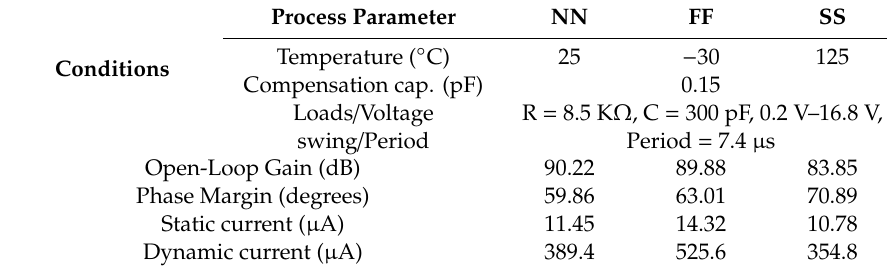
Table 3. Corner simulation results for the proposed bu ff er amplifier (8.5 V @VDD = 17